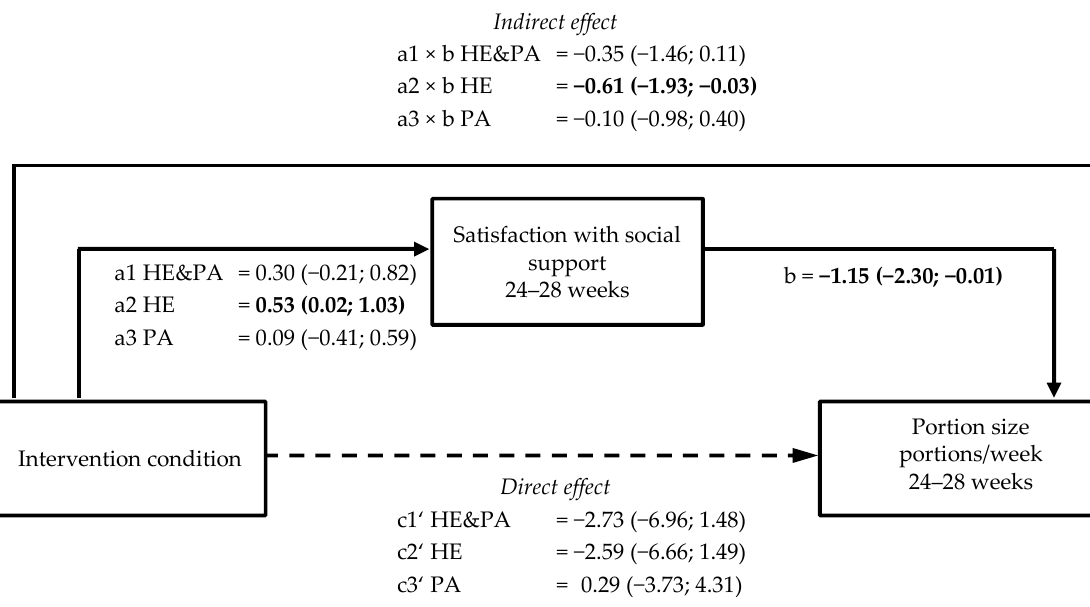
Figure 3. Schematic diagram of the results of mediation by outcome expectancy or satisfaction with social support on portion size. Shown are the path coefficients between intervention condition, outcome expectancy of risk reduction of the baby at 24–28 weeks, and portion size at 24–28 weeks ( A ) and between intervention condition, satisfaction with social support, and portion size at 35–37 weeks ( B ). Statistically significant path coefficients are shown in bold and with solid lines. Dashed lines indicate non-significant paths. Indirect effects were calculated as the product of the coefficients of the a and b paths (a × b).